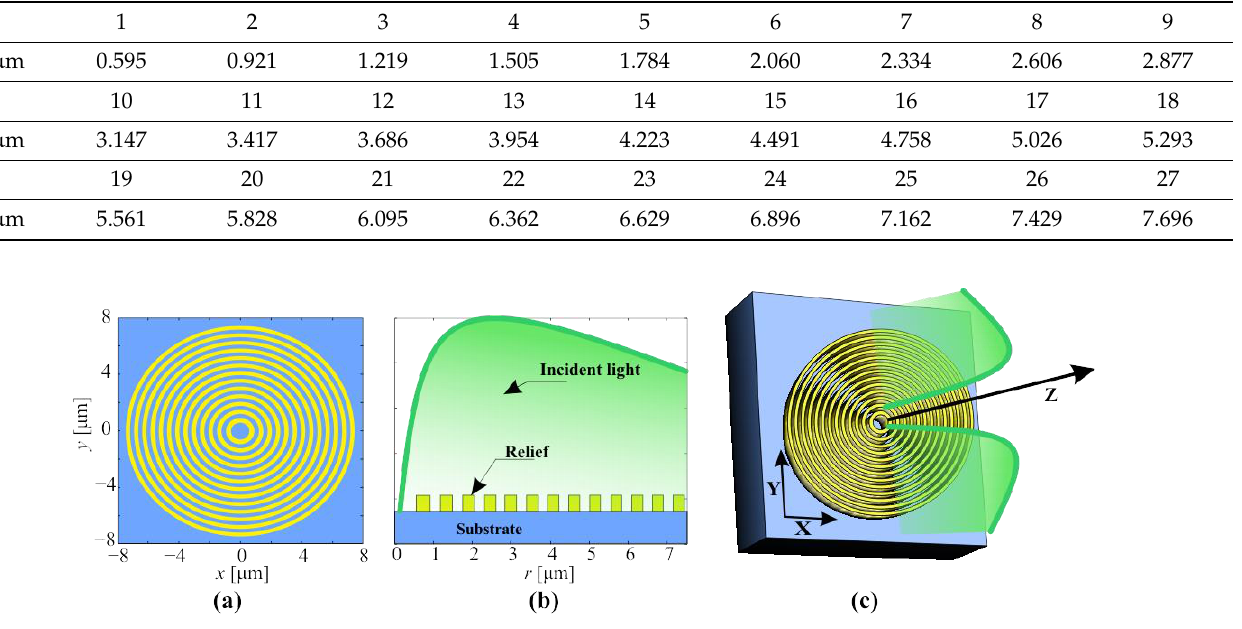
Table 2. Parameters for the Sellmeier ‘s permittivity model of quartz calculated using experimental results in